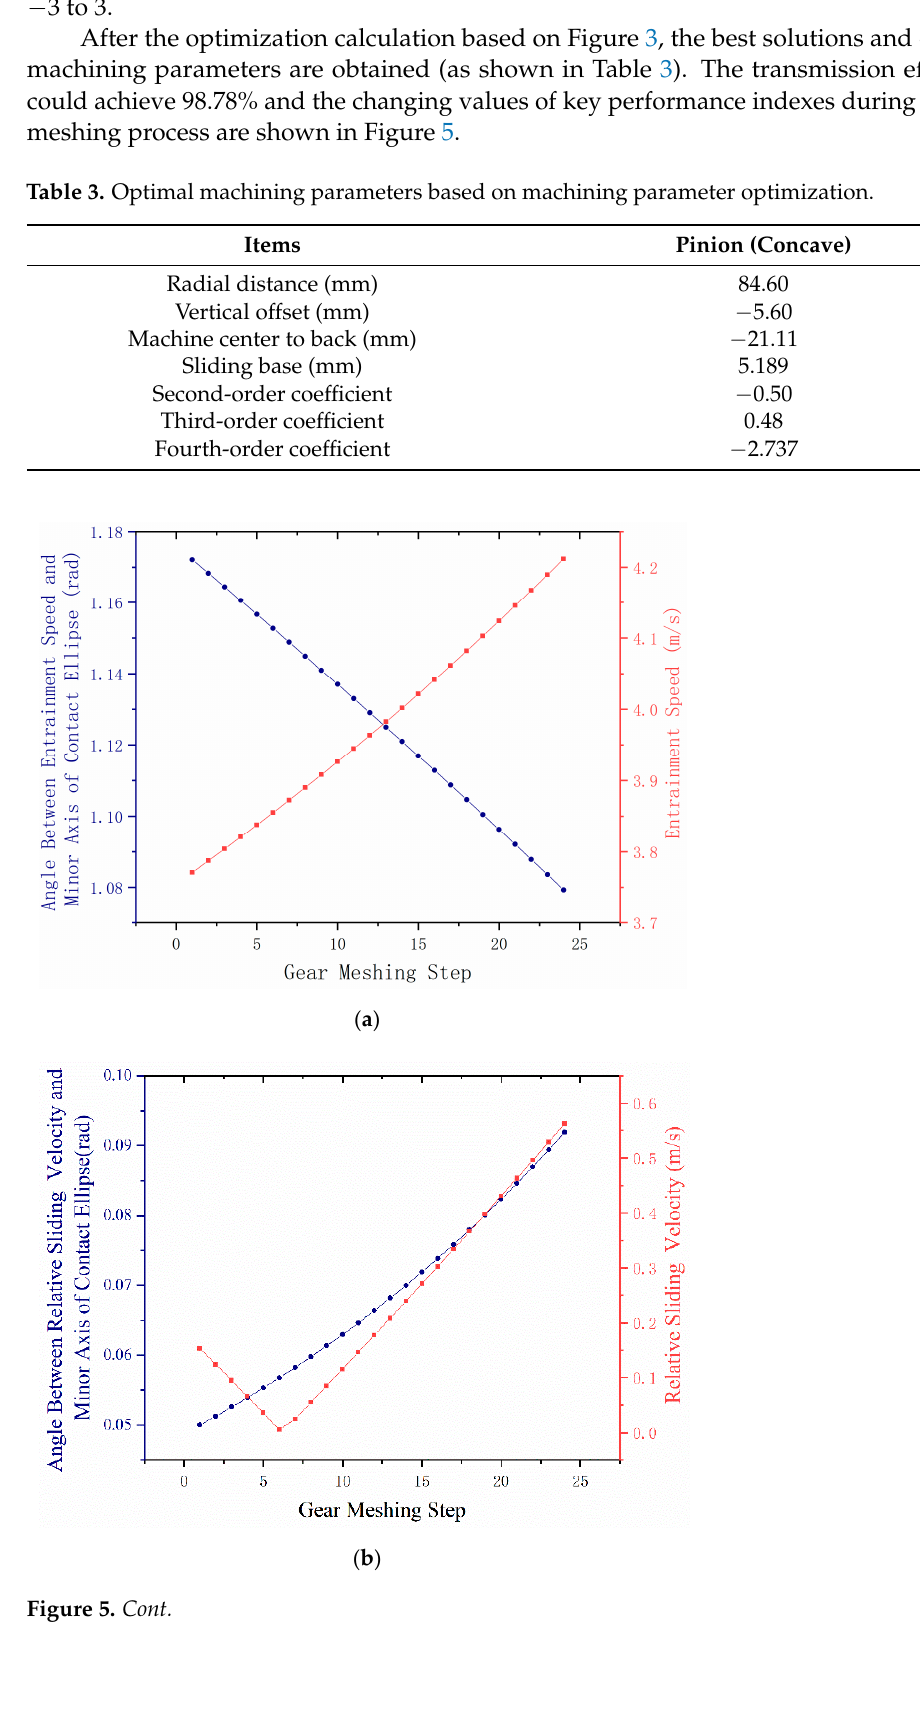
Table 3. Optimal machining parameters based on machining parameter optimization.